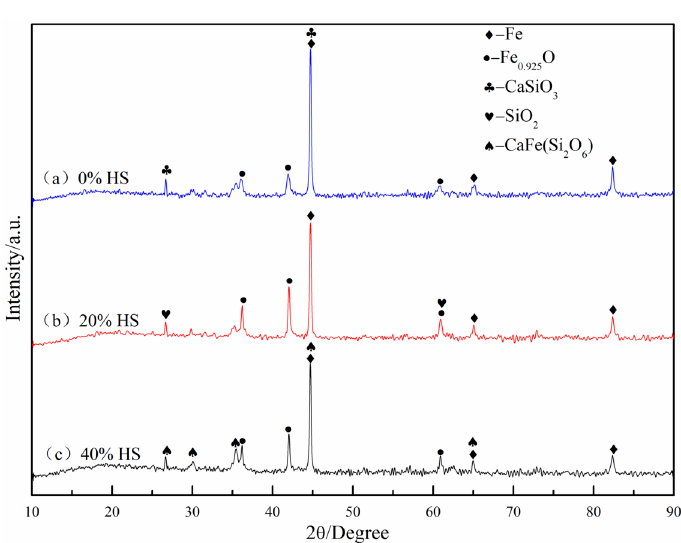
Figure 16. X-ray diffraction analysis of the oxidized pellets with sea sand ore reduced at 900 °C for 3 h.